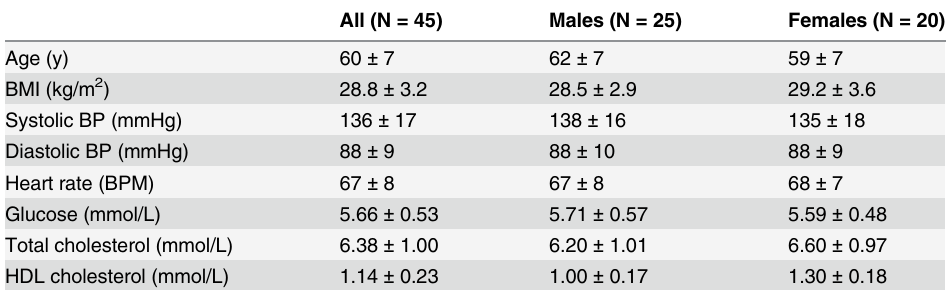
Table 1. Baseline characteristics of participants. 1,2